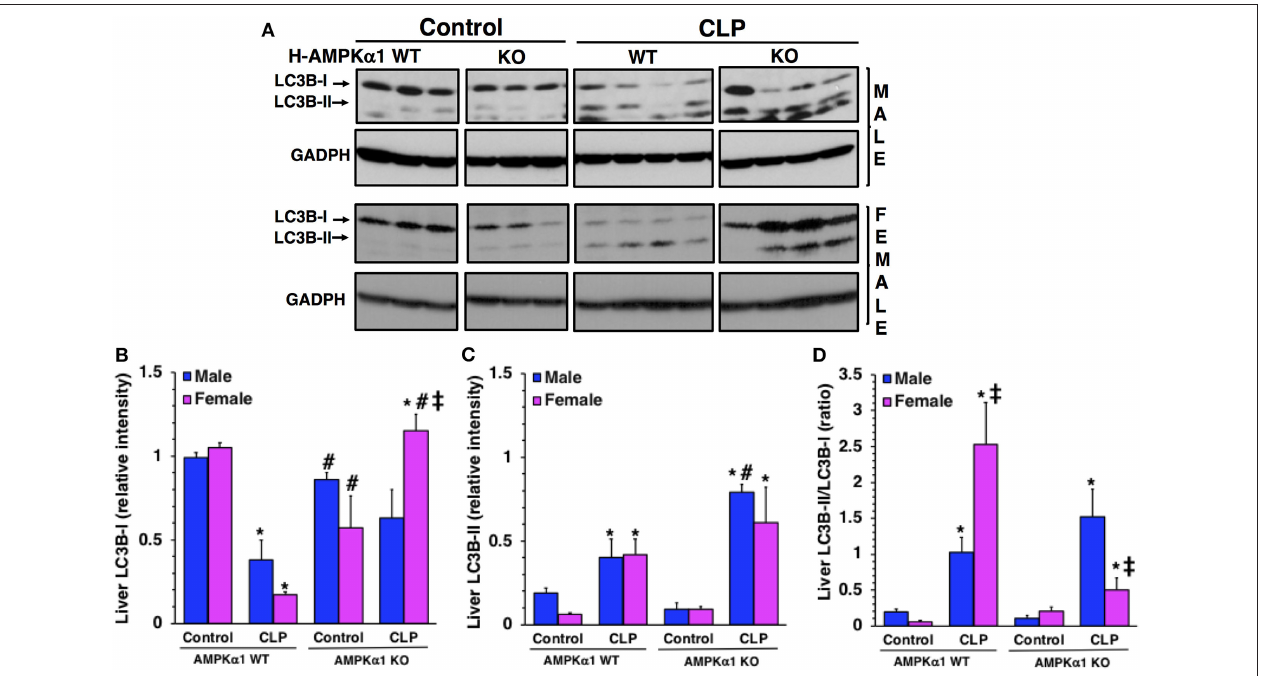
FIGURE 3 | Representative Western blots of protein expression of LC3B-I and LC3B-II in liver cytosol extracts; GADPH was used as loading control protein (A) . Image analyses of cytosol relative intensity of LC3B-I (B) , LC3 B-II (C) and LC3B-II/LC3B-I (D) as determined by densitometry. Each data represents the mean ± SEM of 3–4 animals for each group. * P < 0.05 vs. sex-matched control mice; # P < 0.05 vs. sex-matched WT mice; ‡ P < 0.05 vs. male group of the same genotype.